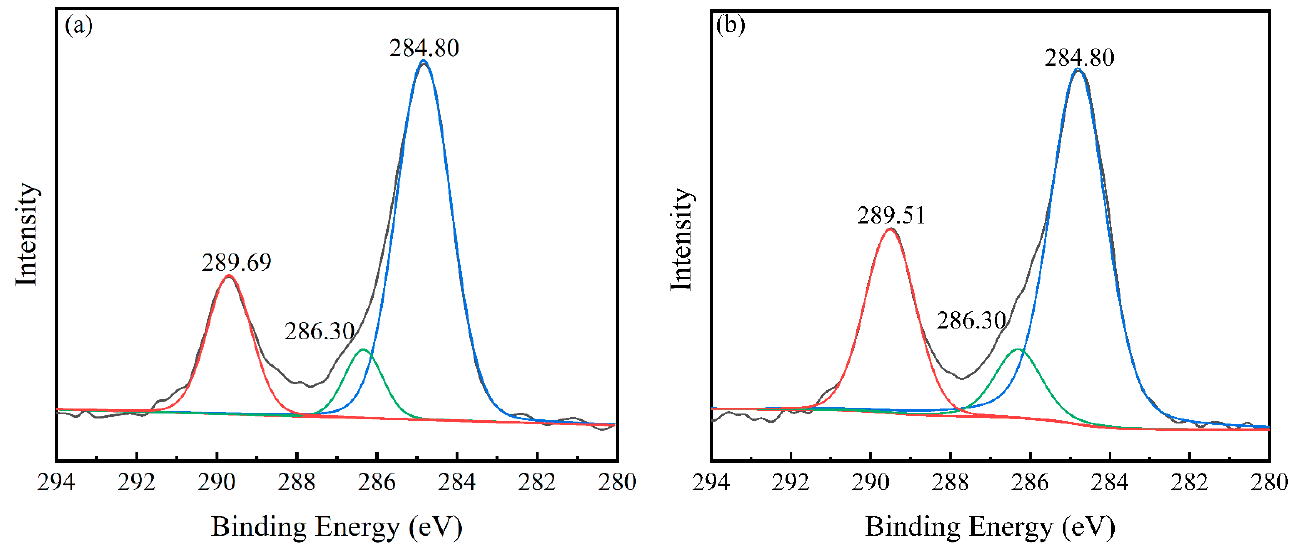
Figure 6. C1s XPS spectra of malachite surfaces as follows: ( a ) treated with Na 2 S, ( b ) treated with (NH 4 ) 2 S, Na 2 S = 6 × 10 − 2 mol/L, (NH 4 ) 2 S = 6 × 10 − 2